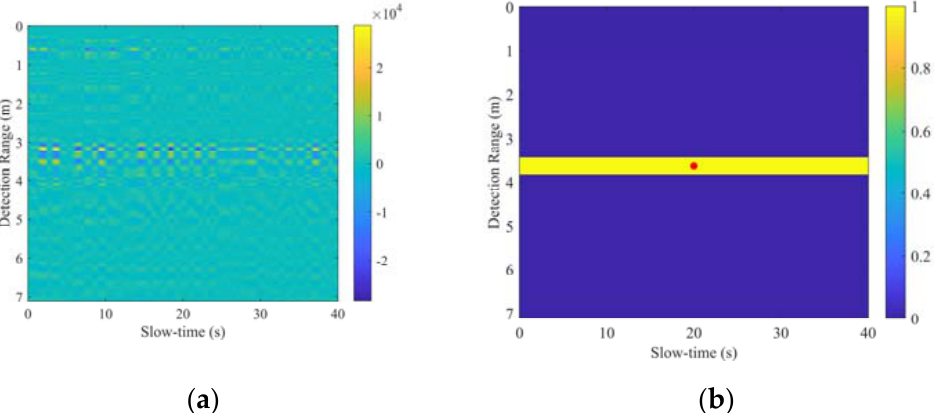
Figure 5. Raw radar data of the experiment with a single target.